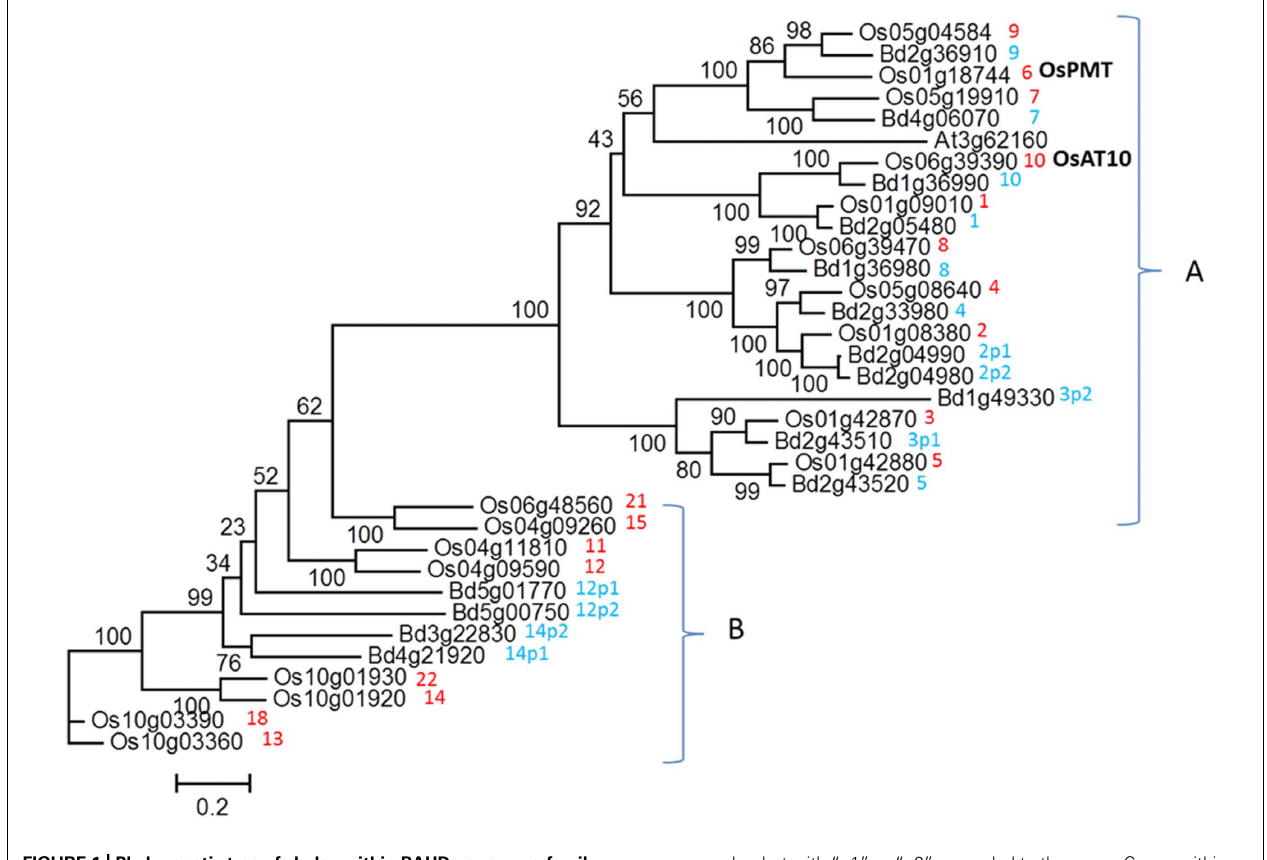
same number but with “p1” or “p2” appended to the name. Genes within clade A are generally more highly expressed than those in clade B.The recently identified monolignol p CA transferase Os PMT (Withers etal., 2012) and OsAt10 (involved in p CA addition to xylan; Bartley etal., 2013) genes are